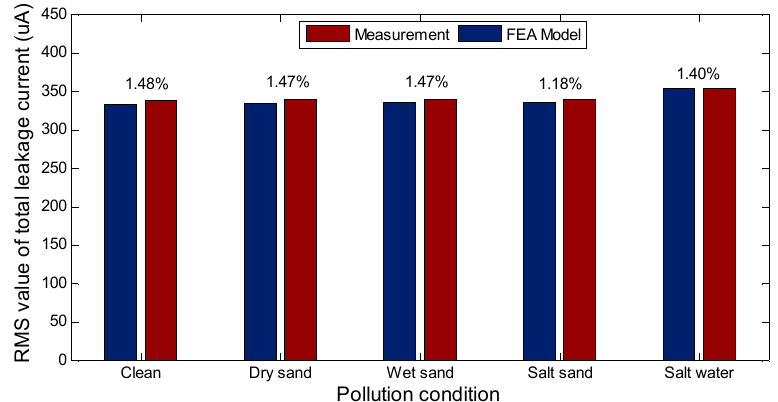
Figure 12. Comparison of RMS value of total leakage current between measurement and FEA model under different artificial pollution conditions.